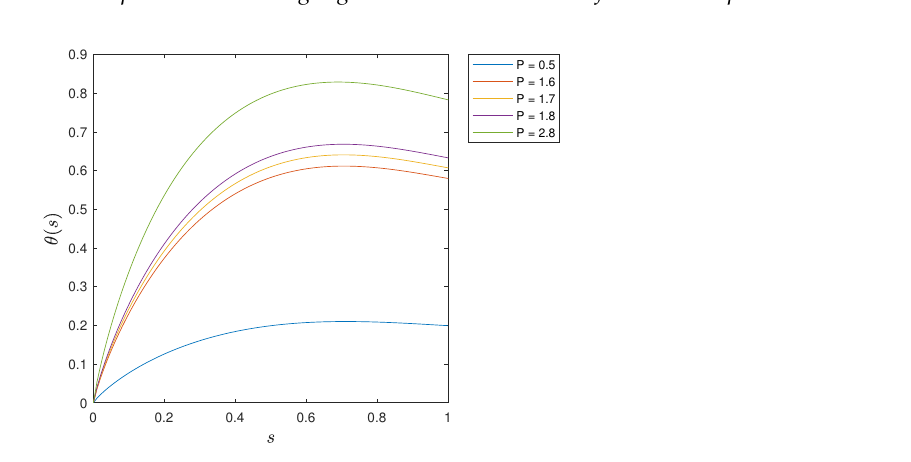
Figure 4. Approximated solutions for θ (tangent angle) of a cantilever beam with a uniformly distributed load P = 0.5,1.7, and 2.8 when α = 0.85.